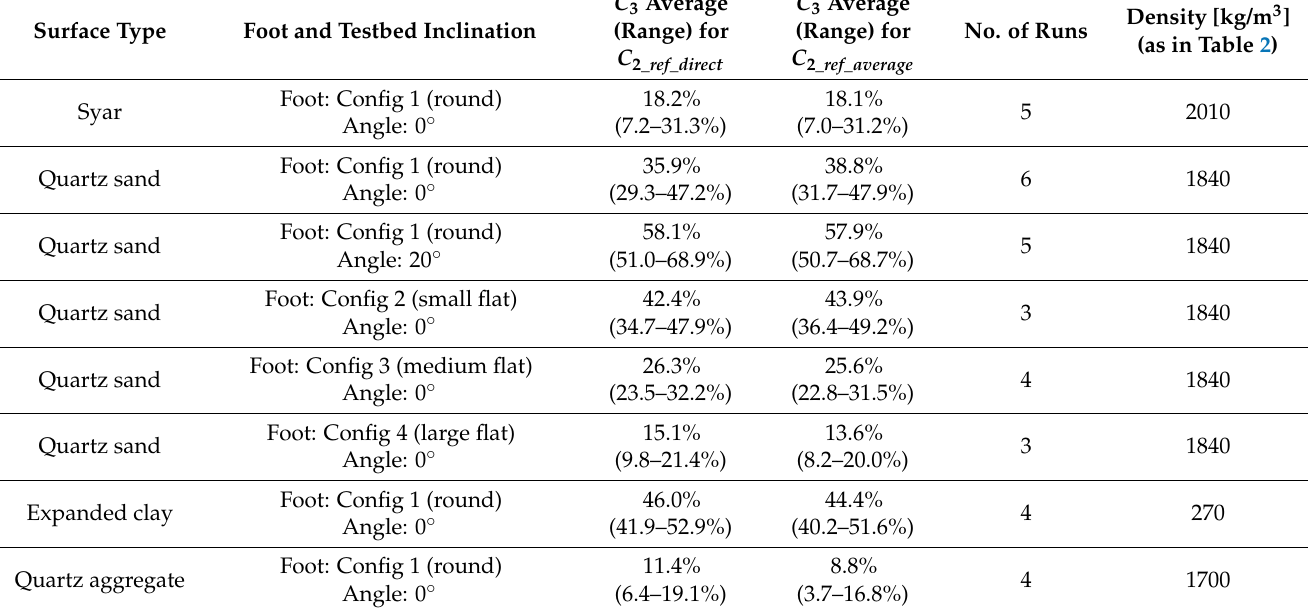
Table 5. Results synthesis for calculations of coefficient C 3